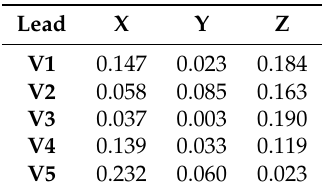
Table 3. Coefficients for the P wave (PLSV)